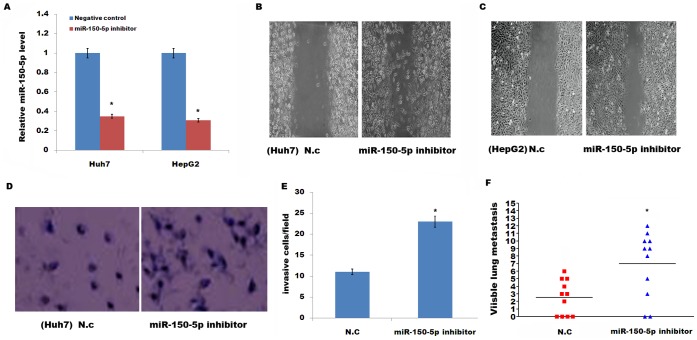
miR-150-5p knockdown promotes hepatoma cell migration and invasion.(A) Quantitative RT-PCR analysis of miR-150-5p expression after miR-150-5p inhibitor treatment in Huh7 and SMMC 7721 cells. * p<0.05. (B and C) Cell migration assay of Huh7 cells (B) or HepG2 cell (C) after miR-150-5p knockdown for 48 h. (D and E) Cell invasion assay of Huh7 cells after miR-150-5p knockdown. Data are shown as the mean ± SD based on at least three independent experiments. *p<0.05. (F) Incidence and number of visible metastases per lung in each cohort following subcutaneous inoculation. *p<0.05.